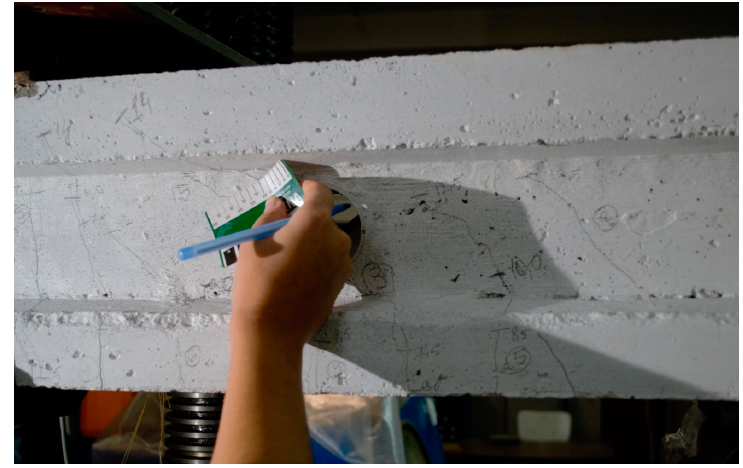
Figure 2. Marking and mapping cracks.